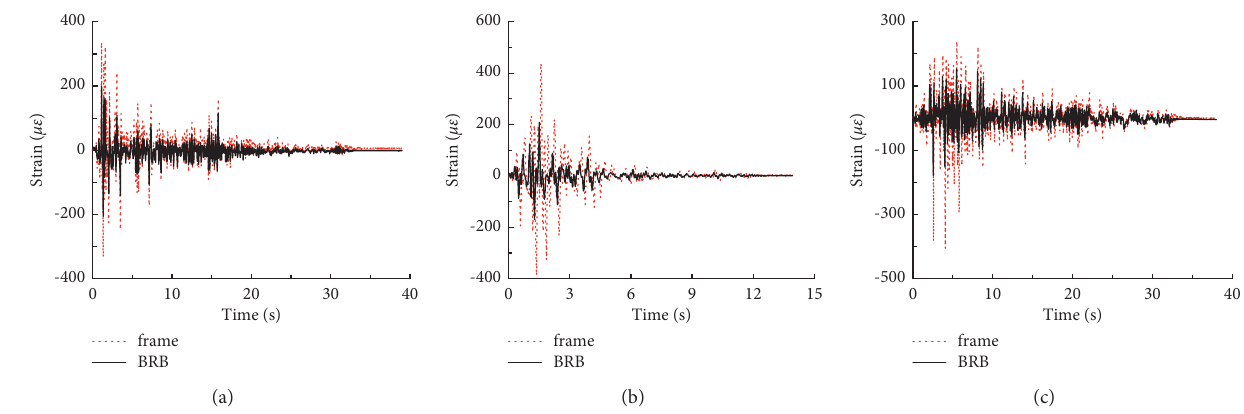
Figure 17: Time-history curves of stain at the bottom of column. (a) El Centro wave. (b) Kobe wave. (c) Taft wave.